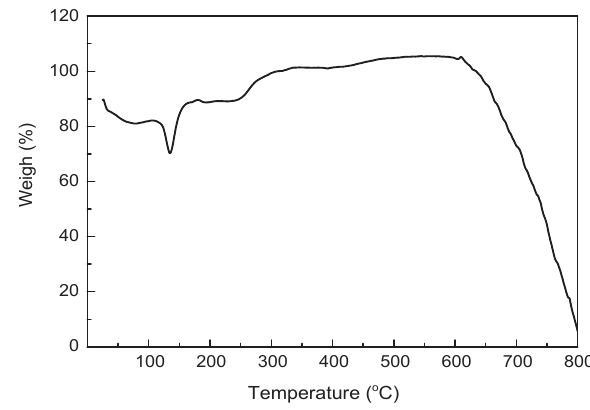
Figure 6: The TG analysis of raw